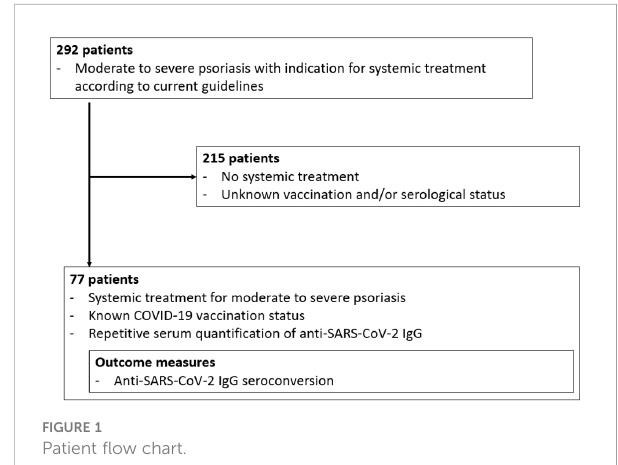
FIGURE 1 Patient fl ow